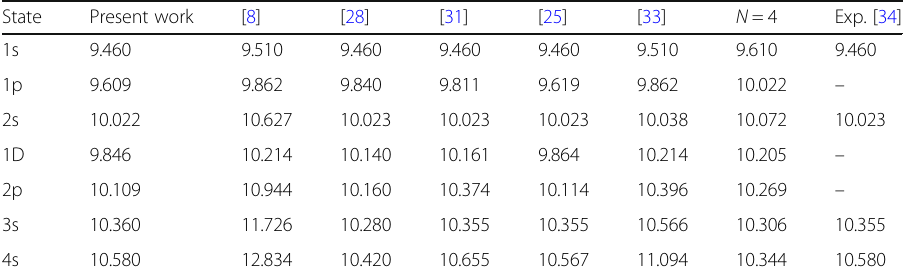
Table 2 Mass spectra of bottomonium (in GeV) ( m b = 4.823 GeV, a = 0.798 GeV 2 , b = 5.051,